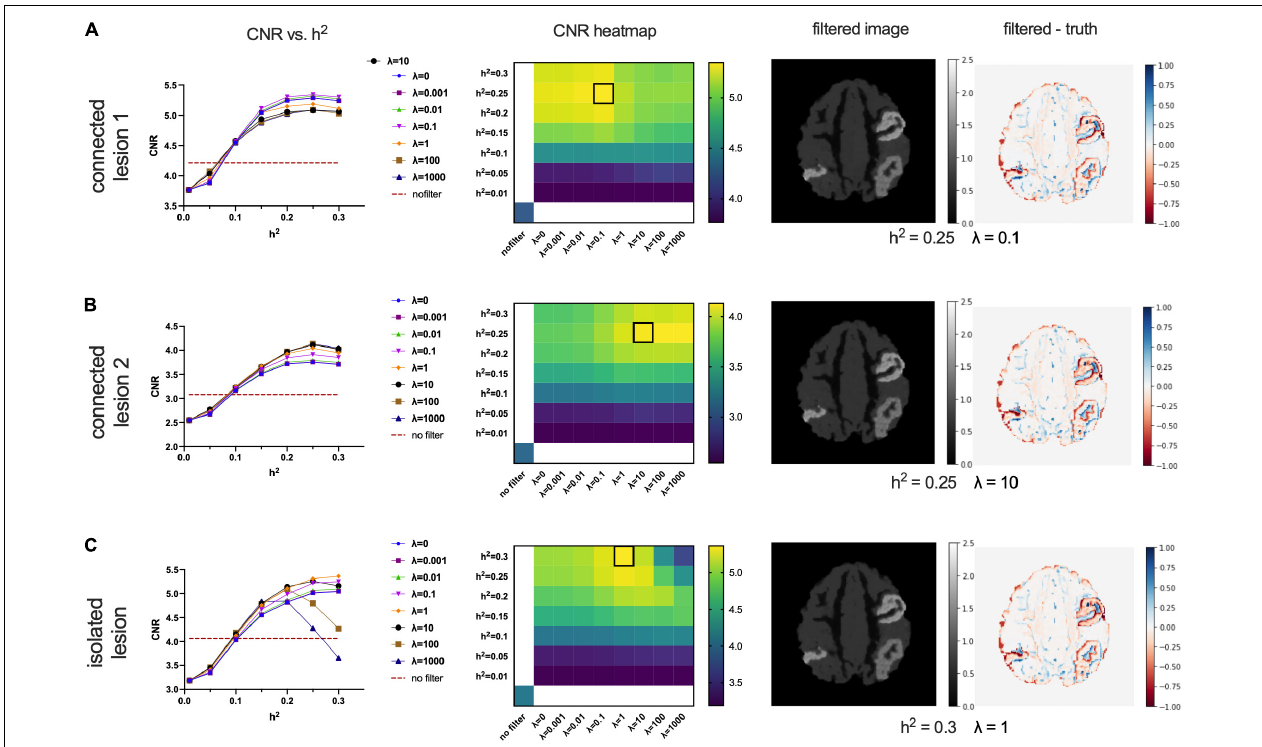
FIGURE 6 | Optimising the filtering strength ( h 2 ) and connectivity ratio ( λ ) according to lesion contrast-to-noise ratios for connected lesion 1 (AAL1), connected lesion 2 (AAL65), and the isolated lesion (AAL66) in the high-count phantom. The first column shows CNR vs. h 2 plots at different λ values, where λ = 0 means only intra-node voxels are included to calculate similarity weights. The horizontal dashed lines indicate the baselined CNR for the noisy PET image without filtering. The second column shows CNR heatmaps; the location of the brightest colour (outlined with a black box) in the CNR heatmaps indicates the preferred h 2 (y-axis) and λ values (X-axis). The last two columns present the filtered images and the corresponding difference maps (filtered – ground truth image). The chosen parameters are h 2 = 0 . 25 , λ = 0 . 1 in panel (A) , which is optimal for the connected lesion in AAL1; h 2 = 0 . 25 , λ = 10 in panel (B) , which is optimal for the connected lesion in AAL65; and h 2 = 0 . 3 , λ = 1 in panel (C) , which is optimal for the isolated lesion in